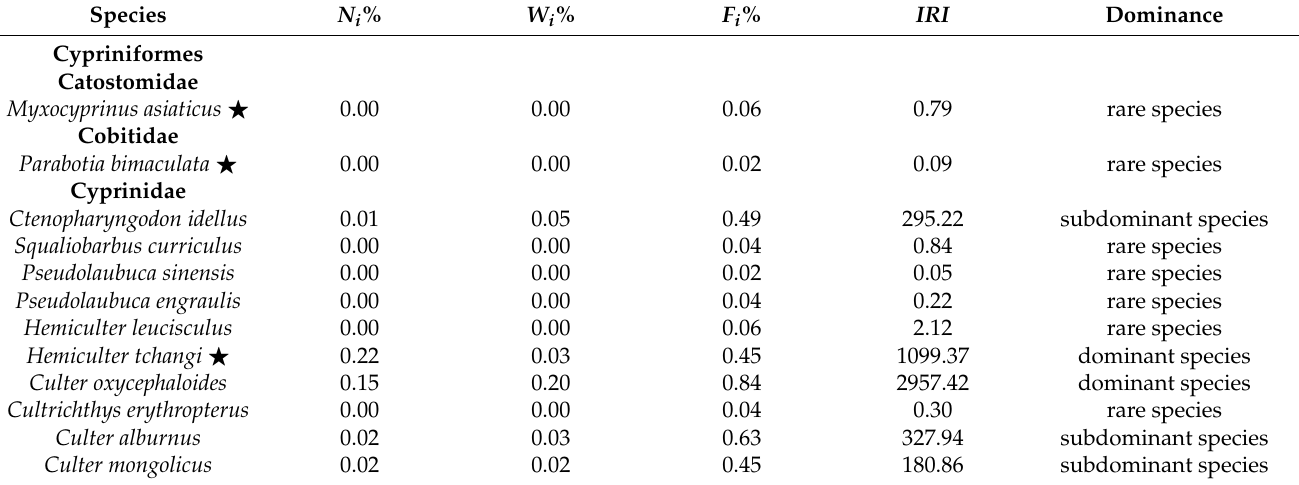
Table 1. Fish composition in the midstream of the Jialing River sampled from December 2021 to November 2022. N % represents quantity percentage, W % represents weight percentage, F % represents occurrence percentage, IRI is the index of relative importance, Dominance is defined according to IRI results and (cid:70) represents endemic fishes of the upper Yangtze